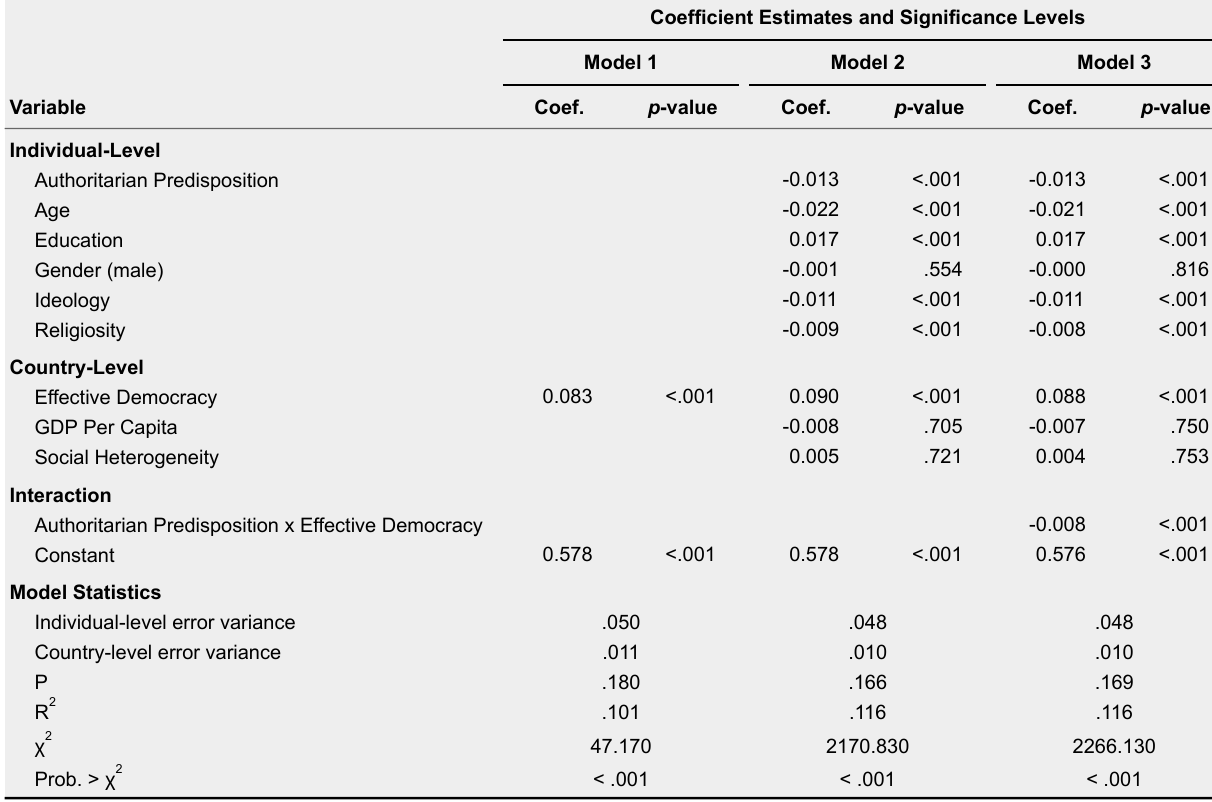
Social Tolerance, Authoritarianism, and Effective Democracy